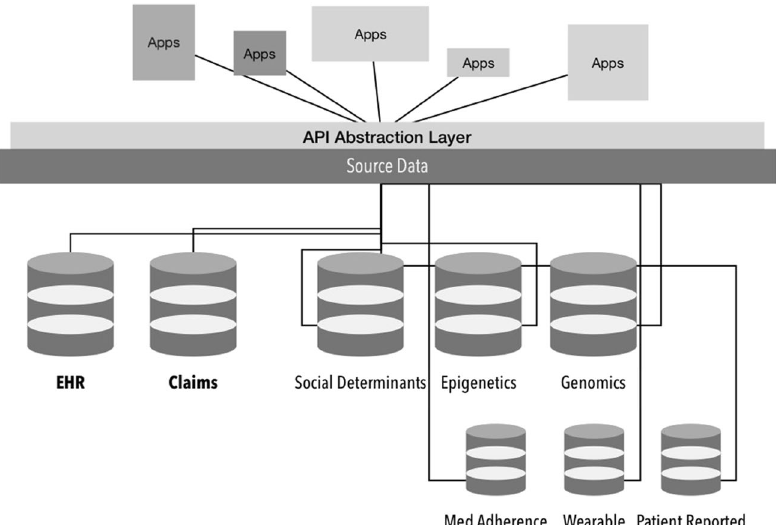
Fig. 1 APIs and an abstraction layer on top of source data. An application programming interface (API) abstraction layer on top of data sources can help make data accessible through applications to facilitate the transaction of data via